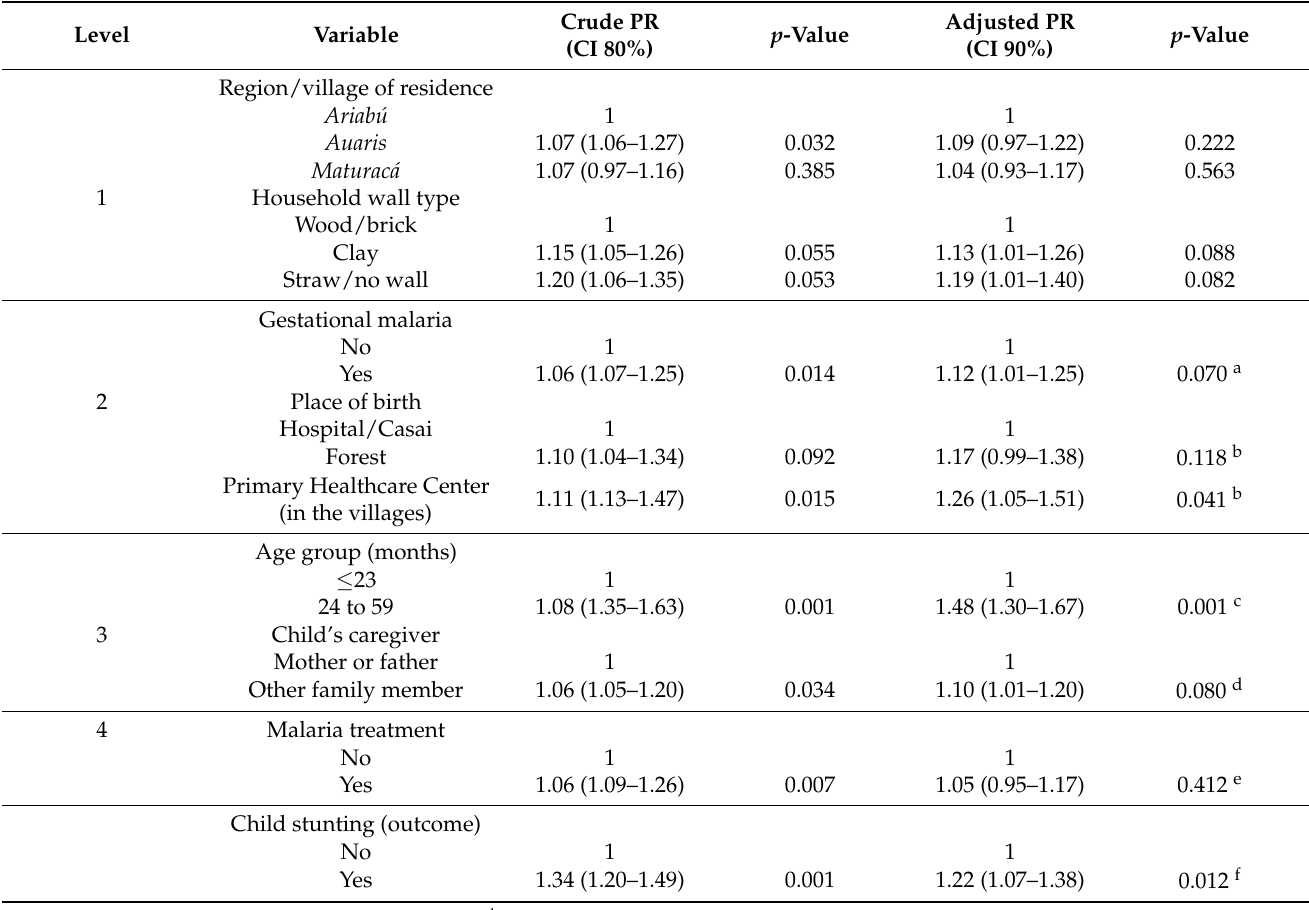
Table 4. Crude and adjusted hierarchical models of the association between stunting in Yanomami children under five years old and short maternal height. Yanomami Indigenous Territory, Brazilian Amazon,